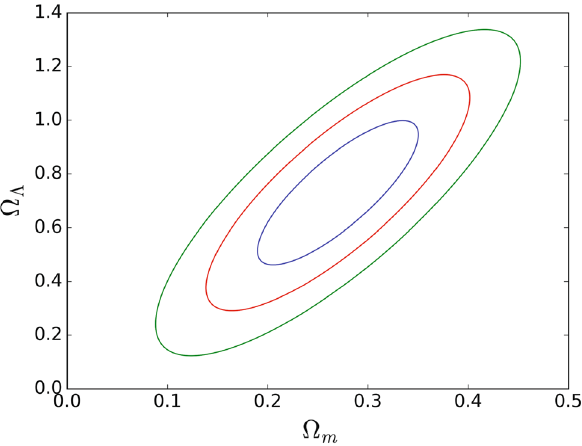
Fig. 12 Same as Fig. 10, but for 10-year-observation simulation. The FoM is 569.42